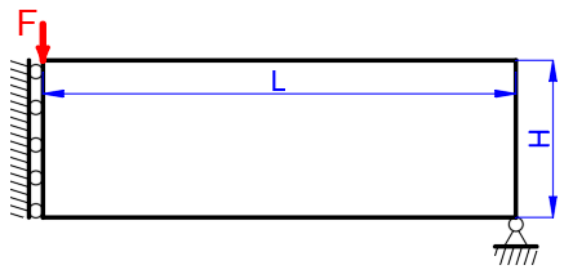
Figure 5. The Messerschmidt–Bölkow–Blohm (MBB) beam.